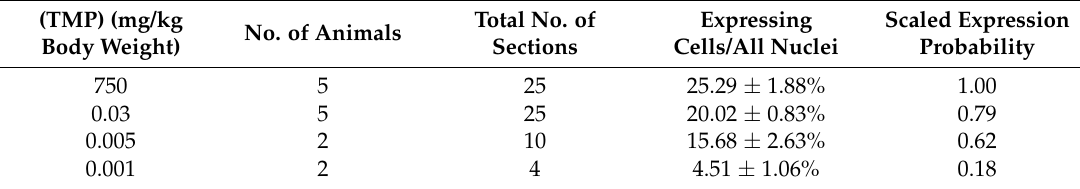
Table 1. Titrated indicator expression